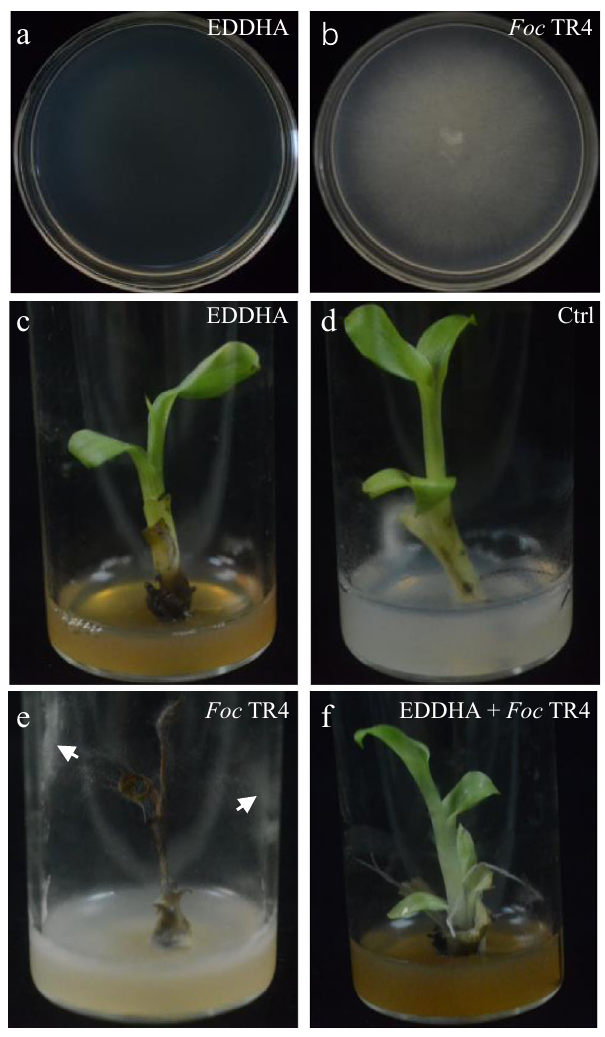
Fig. 5 Iron-chelating suppresses Foc TR4 growth and inhibits Fusarium wilt disease of banana. a Addition of EDDHA ( fi nal concentration of 4 mM) suppressed growth of Foc TR4. b Foc TR4 grew normally on PDA medium. c , d banana plantlets grew in ½ MS medium with ( c ) or without ( d ) 4 mM EDDHA. e A banana plantlet died when grew in ½ MS medium containing a small Foc TR4 medium plug, and the white arrows indicate Foc TR4 hyphae. f A banana plantlet grew in ½ MS medium containing 4 mM EDDHA and a small Foc TR4 medium plug. One representative of the plantlets ( n = 5) in each treatment was taken a